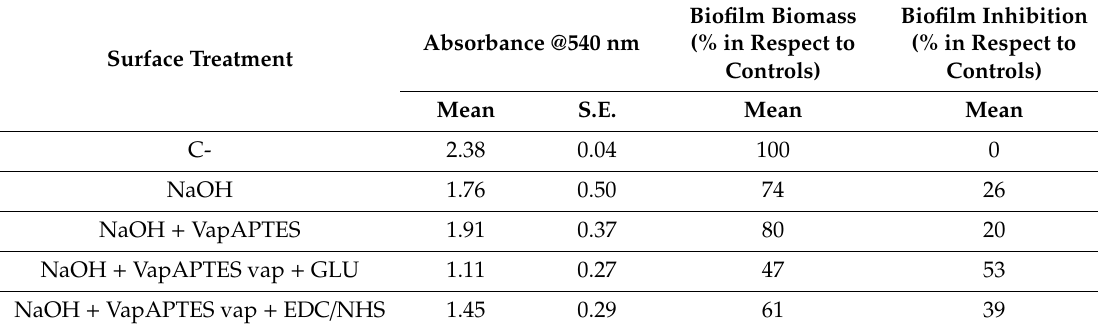
Table 2. Results summary of the microbiological tests. Mean and standard error (S.E.) values of the biofilm absorbance measured in triplicate experiments at different steps of the production process. Estimated biofilm biomass and inhibition percentages are calculated in respect to the amount of biofilm grown on controls.